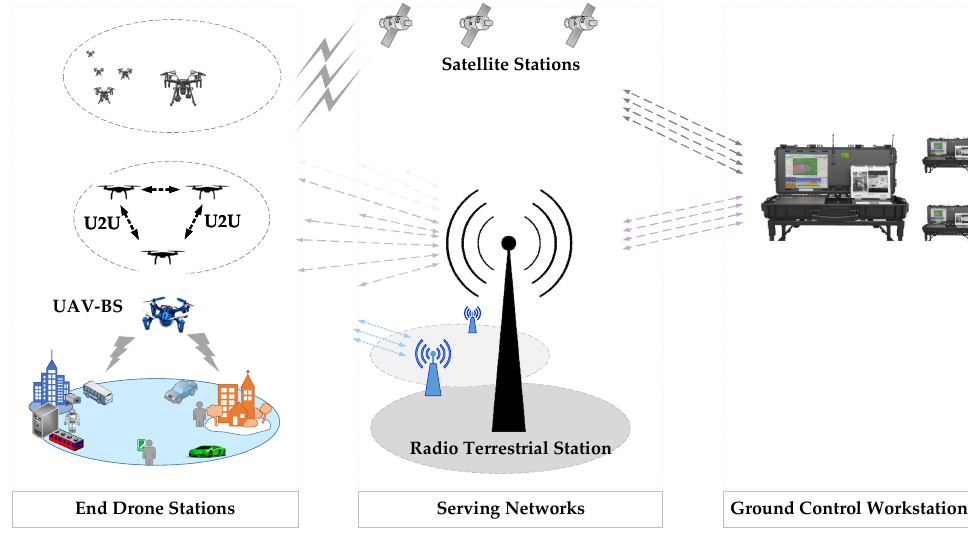
Figure 3. Drone system architecture.